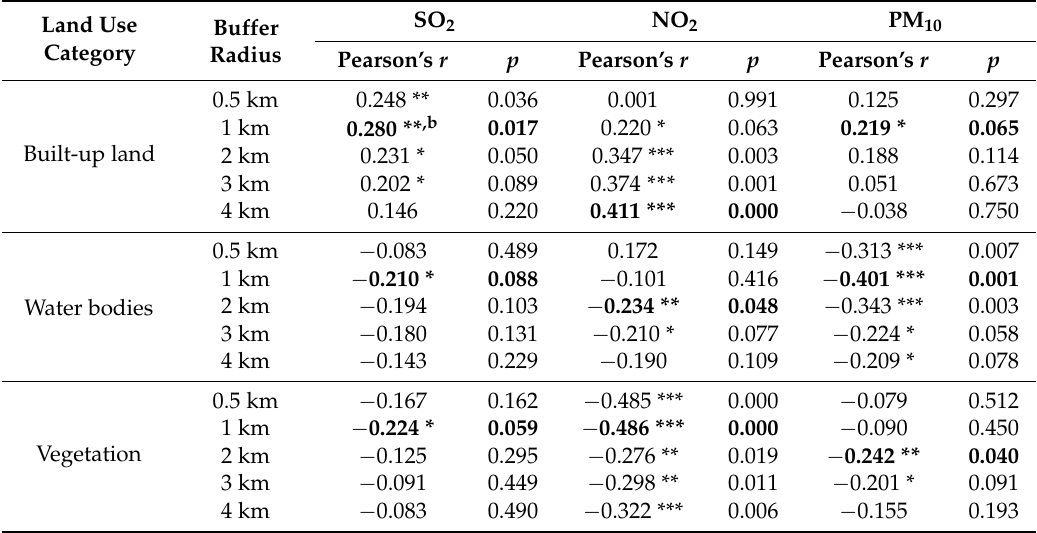
Table 3. Results of bivariate correlation analysis between land use variables and air pollutants ( N = 72). Land